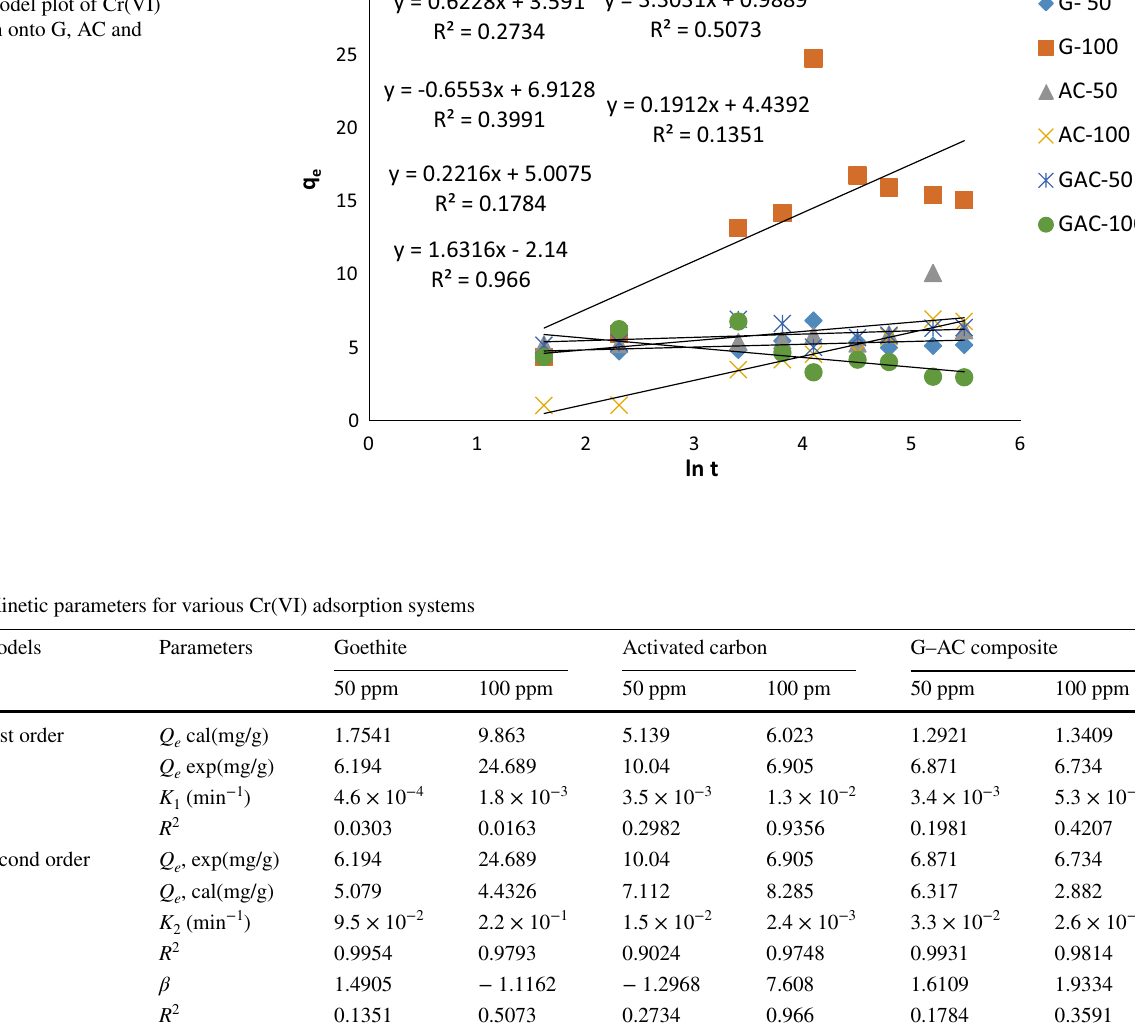
Fig. 15 Linearized plot of Elovich model plot of Cr(VI) adsorption onto G, AC and GAC